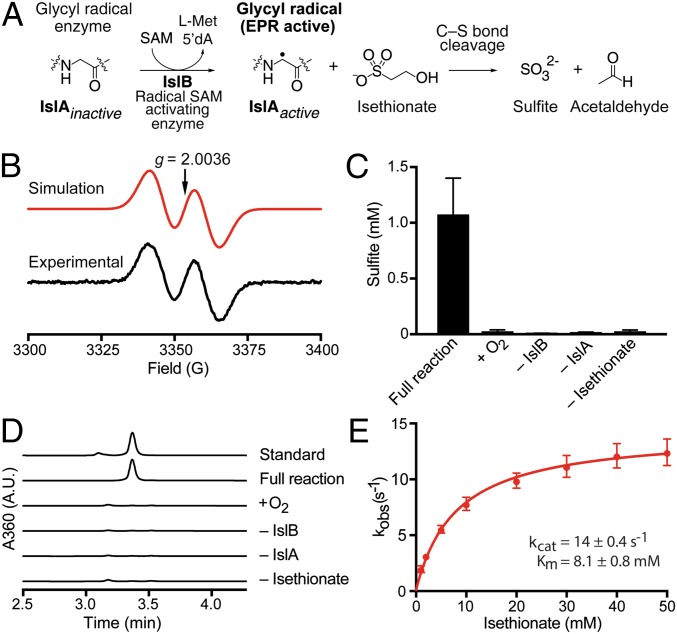
The B. wadsworthia GRE is a C-S bond-cleaving IslA. (A) The GRE-activating radical SAM enzyme IslB installs a protein-centered, stable glycyl radical within the GRE IslA. Activated IslA then catalyzes a C-S bond-cleavage reaction with isethionate as the substrate. The mechanistic hypothesis is illustrated in SI Appendix, Fig. S1B. (B) Electron paramagnetic resonance spectroscopy demonstrating glycyl radical formation on recombinantly produced and purified IslA after its activation by recombinant purified and reconstituted GRE-activase IslB. (C) Conversion of isethionate to sulfite by IslA was observed only in the absence of molecular oxygen and in the presence of all reaction components, as was acetaldehyde formation (D). The data in C are shown as the mean ± SD of three technical replicates, and data in D are shown as representative HPLC chromatograms of a minimum of two technical replicates. (E) The Michaelis–Menten kinetics of isethionate cleavage were determined by using a coupled spectrophotometric assay with yeast alcohol dehydrogenase and NADH. The kcat was 14 ± 0.4 s−1, and the Km was 8.1 ± 0.8 mM. Data are shown as the mean ± SD of four technical replicates.